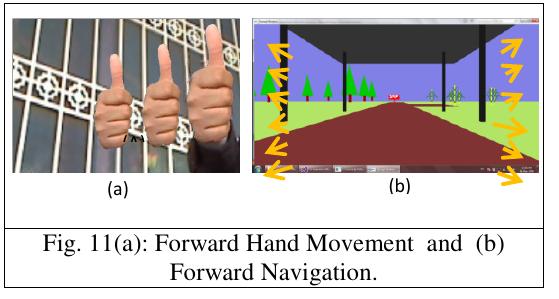
Fig. 11(a): Forward Hand Movement and (b) Forward Navigation.